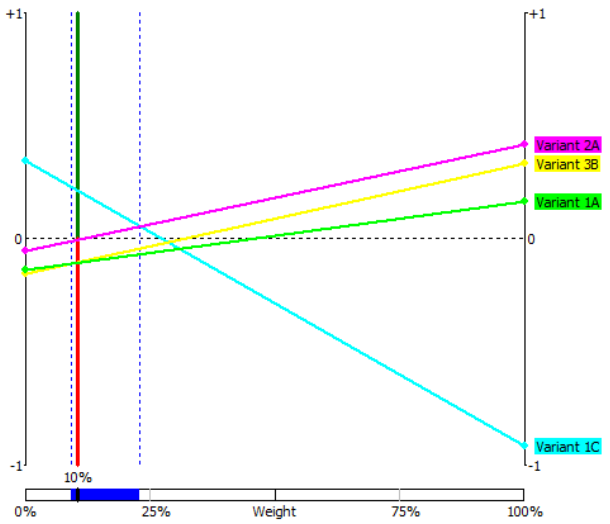
Figure 7. Sensitivity analysis of the constructional-technical criteria.